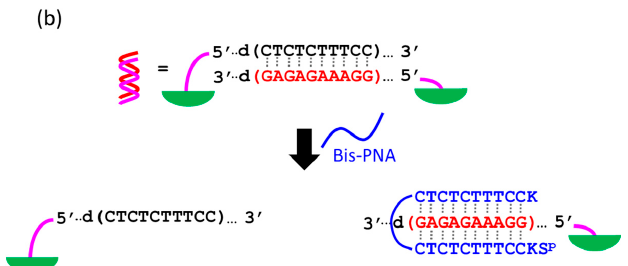
Figure 7. Structures of nanomechanical DNA origami devices used to visually detect PNA invasion. ( a ) Schematic illustration of the system; and ( b ) structures of the pre-closing zipper elements and PNA.